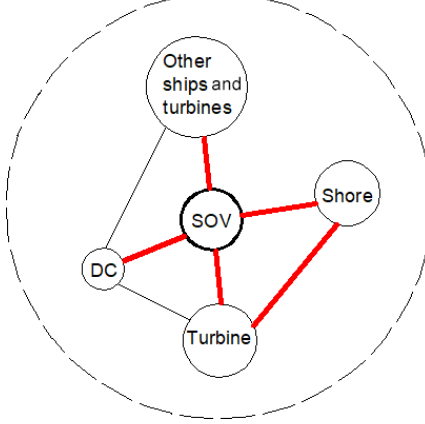
Figure 4. System components and system boundary (SOV: service operation vessel, DC: daughter